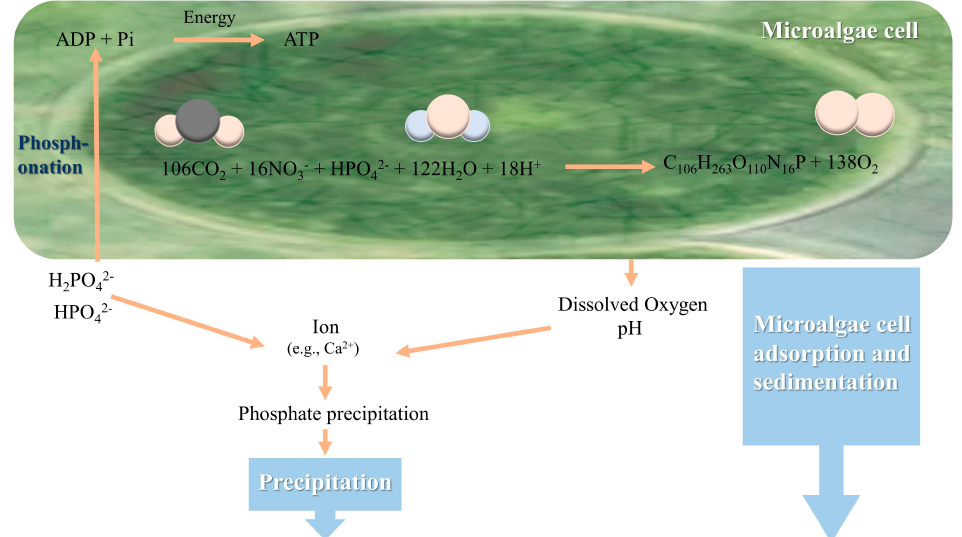
Figure 5. Mechanism of adsorption of settling phosphorus by microalgae.